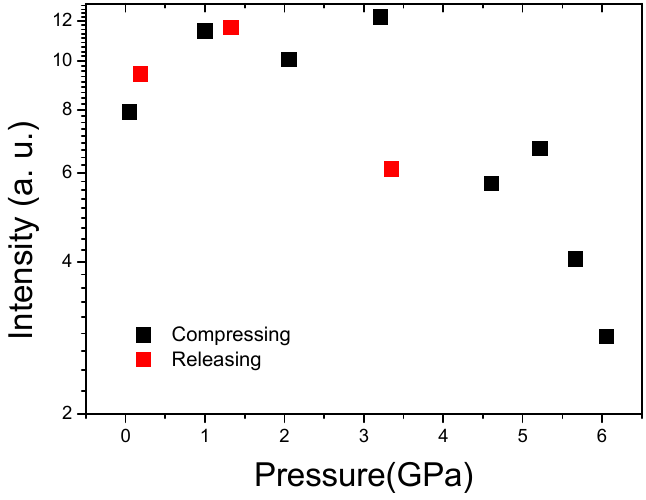
Figure 9. Integrated intensity pressure dependence of the [(CuBr) 2 (Quin)] compound. In the [(CuI) 2 (Quin)] compound, two different excitation wavelengths were used to obtain the emission spectra, resulting in similar observed behaviors.